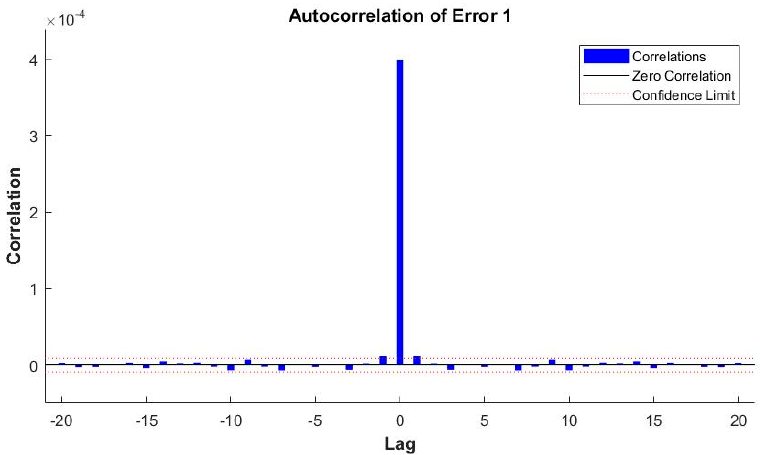
Figure 13. The error autocorrelation function when forecasting the electricity consumption for the month of December, using the ANN_NARX_BR_ALL network.